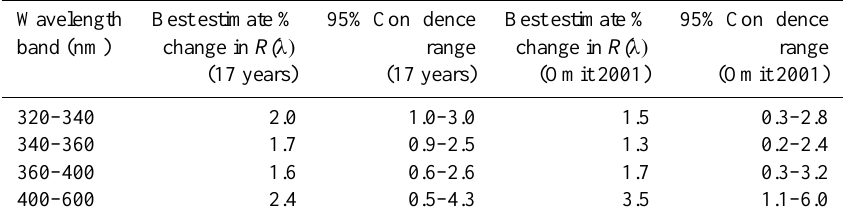
Table 6. Percentage change in irradiance ratio for a 100-Unit Change in 10.7cm solar radio flux (based on the regression models).